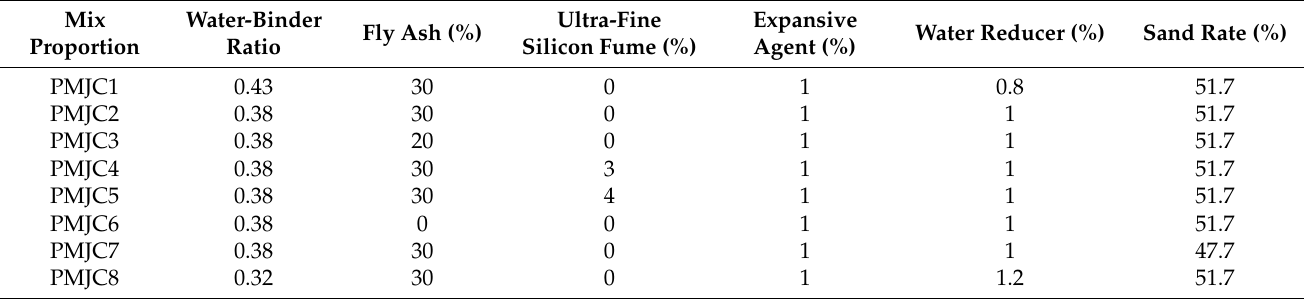
Table 3. Mix proportion of PMJC.